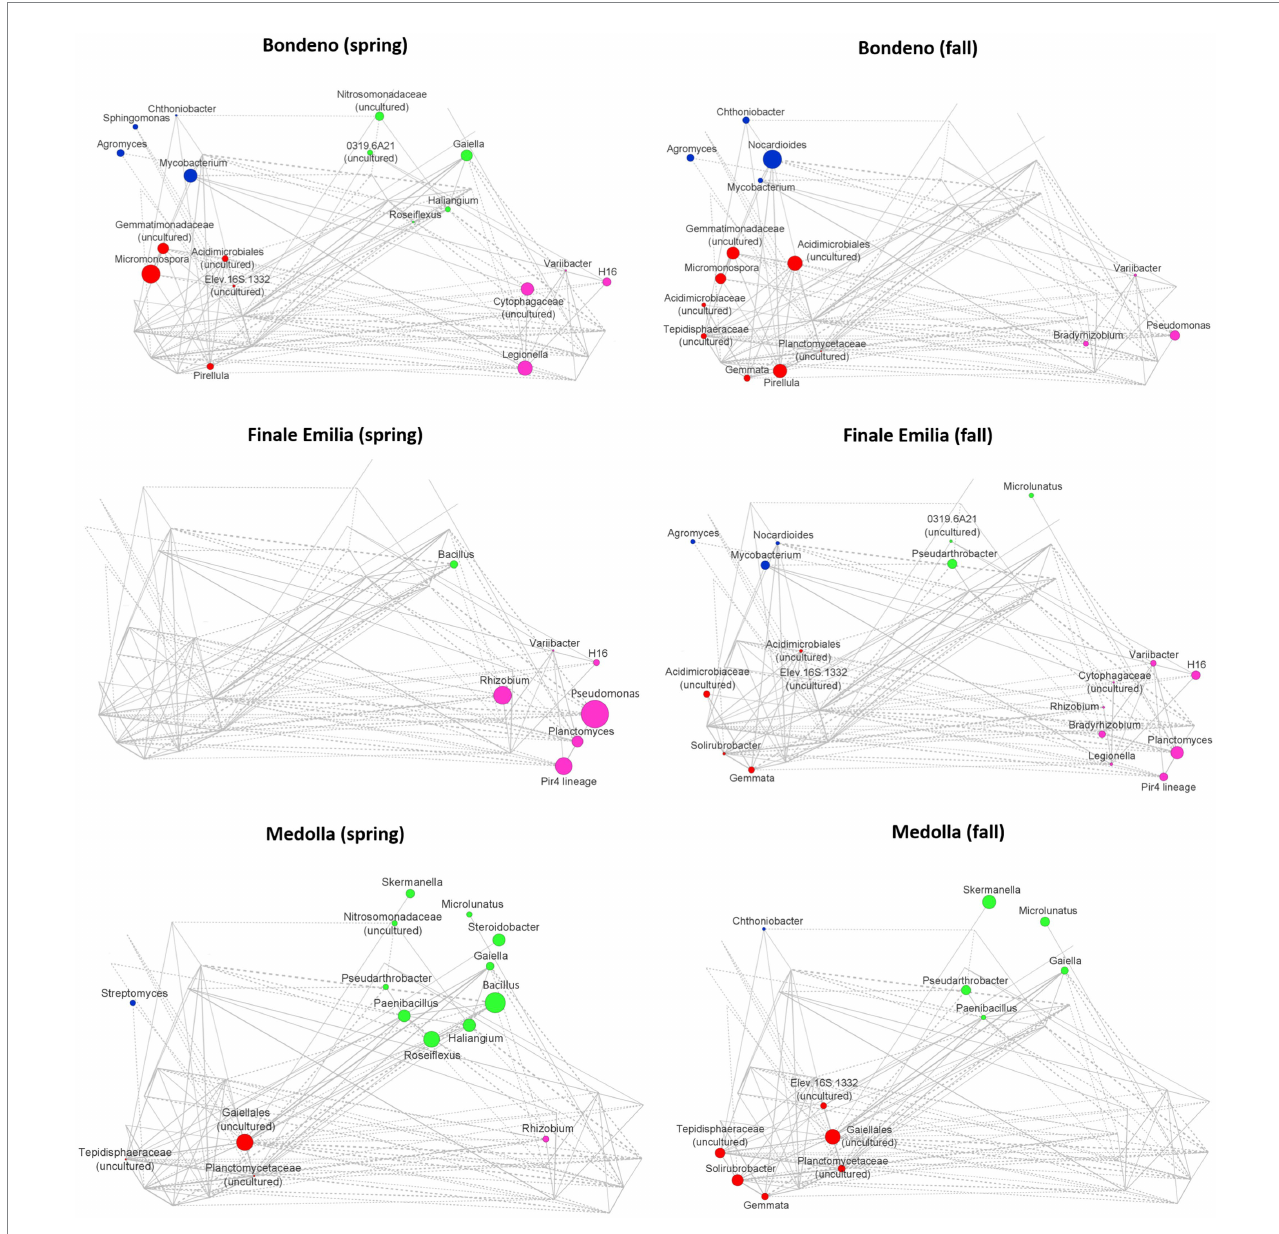
FIGURE 5 Declination of rhizospheric Vitis vinifera co-abundance groups according to the sampling site and to seasonality. Co-abundance groups (CAGs) are named according to the dominant bacterial genus in each group: Pirellula (red), Nocardioides (blue), Pseudomonas (pink), and Bacillus (green). Each node represents a bacterial genus and the size of the corresponding circle is proportional to its over-abundance on the average value within the population. The connections between nodes constitute positive (solid lines) and negative (dashed lines) Kendall correlations between genera (FDR ≤ 0.05). For CAGs definition see Supplementary Figure